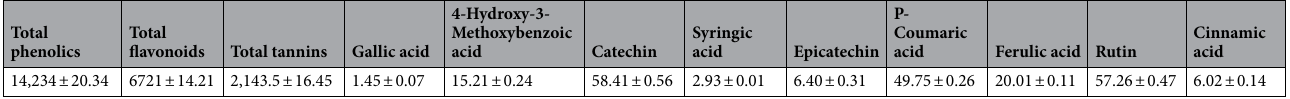
Table 1. Polyphenolic content of VGSE (mg/100 g). Values are means ± SD of three experiments. Analysis was achieved using Breeze software (version 1.15).